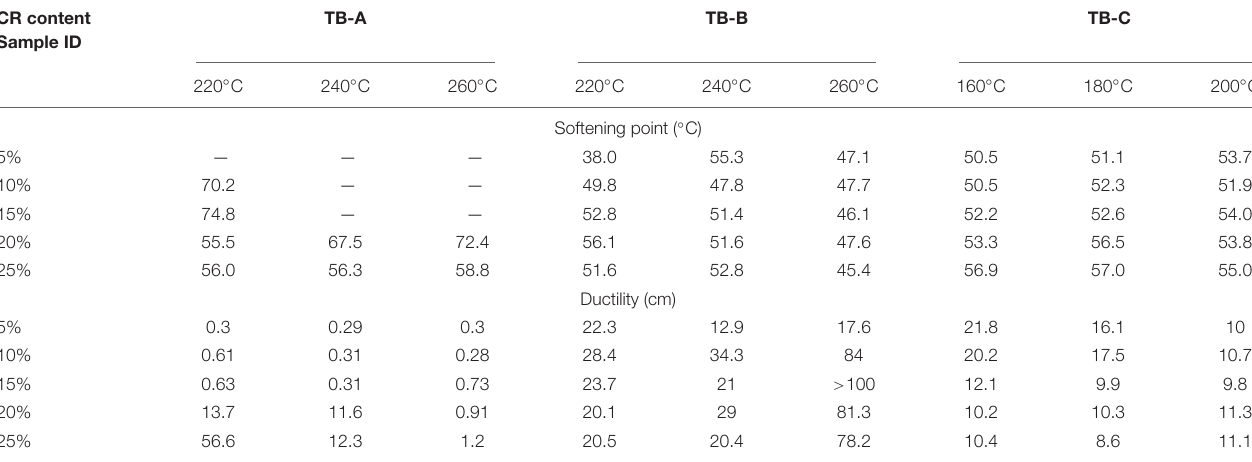
TABLE 3 | Softening point and Ductility test results of TB